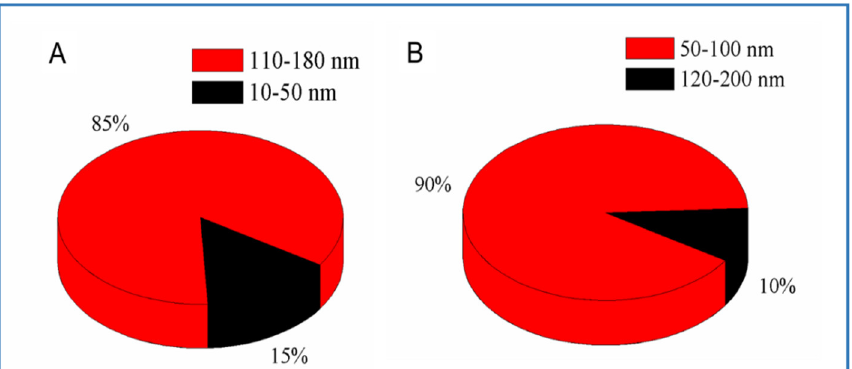
Figure 2. Particle sizes of the blank PF108 micelles ( A ) and QEO-loaded micelles ( B ) determined by DLS.